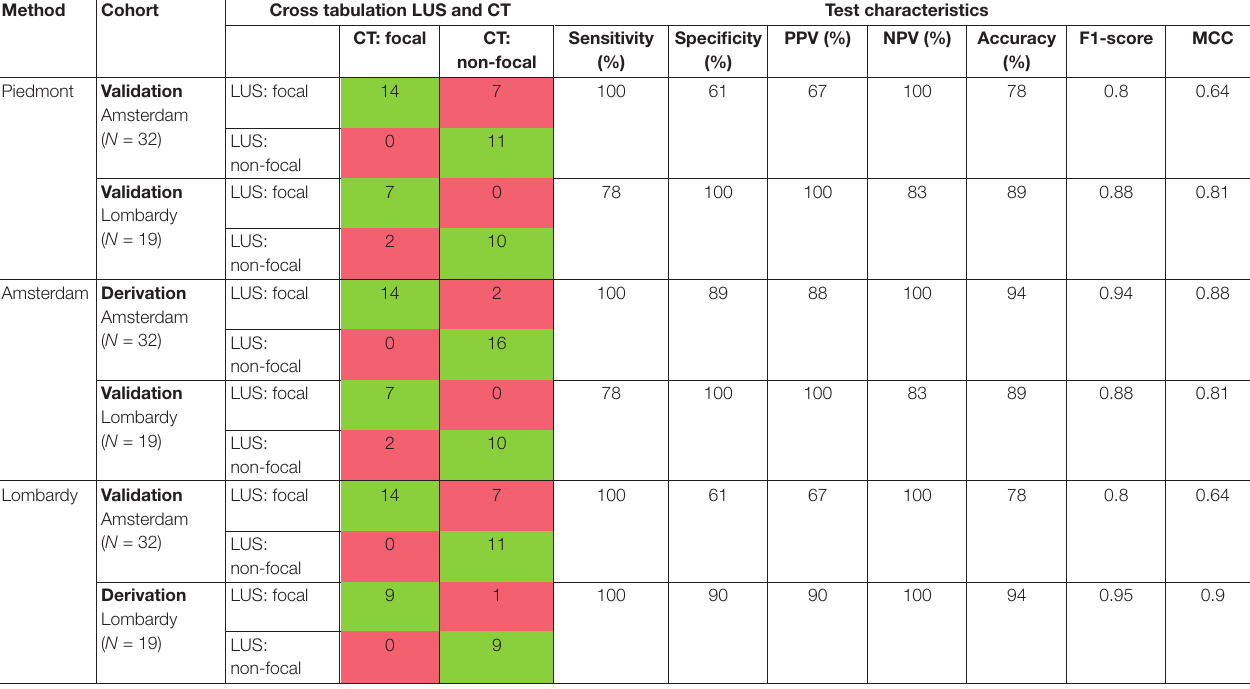
TABLE 2 | Distribution of examined patients according to their lung morphology determined with LUS-based method in comparison to CT findings. Method